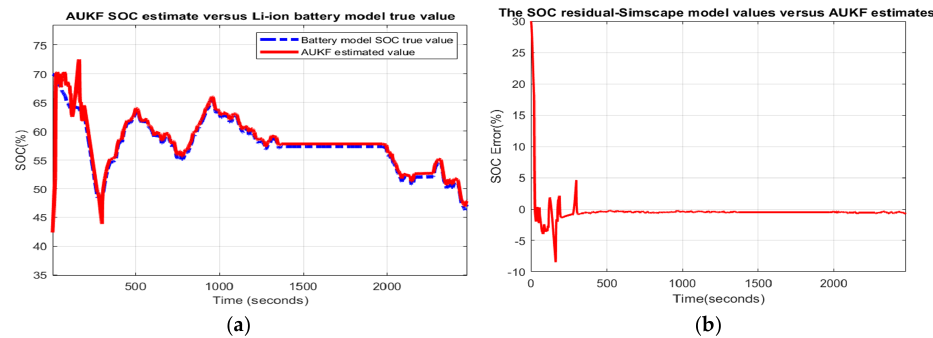
Figure A23. Robustness to simultaneous changes, SOCini = 0.4, σ noise = 0.01; ( a ) AUKF SOC value versus battery model true value; ( b ) SOC residual.